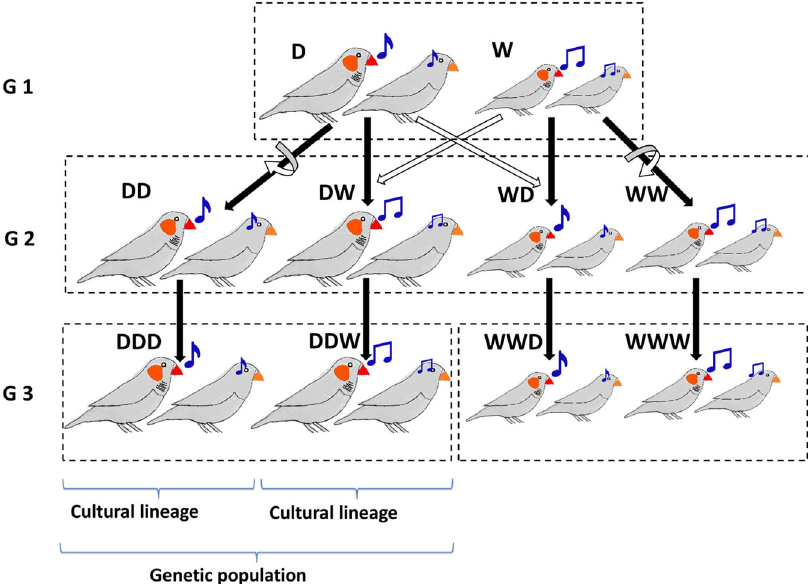
Fig. 3 Schematic representation of the experimental groups across three generations. In Generation 1, assortative mating was tested in groups (indicated by the dashed rectangle) consisting of birds from two populations (one domesticated, D, and one wild-derived, W) that differ genetically (e.g., in body size, indicated by the size of the birds) and culturally (e.g., in song, indicated by the shape of the notes). After testing, the two populations were housed separately and four lineages were created by cross-fostering (solid arrows re fl ect genetic descent, open arrows indicate rearing parents, whereby the curved and straight arrows re fl ect the within- and between-population cross-fostering, respectively). These four lineages (Generation 2) are denoted as DD, DW, WD, WW; the fi rst letter indicates the genetic population of origin and the second indicates the population of the rearing parents. In Generation 2 assortative mating was tested in groups that contained equal numbers of all four types of males and females. After testing, the four lineages were again housed separately and bred without cross-fostering, such that they passed on their culturally acquired traits to Generation 3. In this generation, assortative mating was tested in groups of males and females with a similar genetic background, but that differed in the cultural traits transmitted through the foster grandparents (indicated by the third letter; e.g., DDW corresponds to birds with genetic background D, raised by parents DW from Generation 2). All experiments were performed with two domestic and two wild-derived populations (replicate 1: D 1 -W 1 , replicate 2: D 2 -W 2